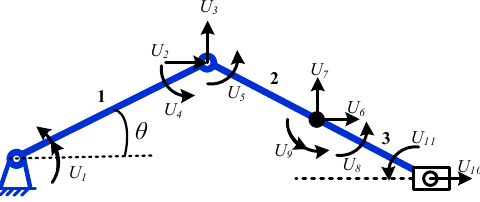
Figure 8. The model of the simplified expanding arm.